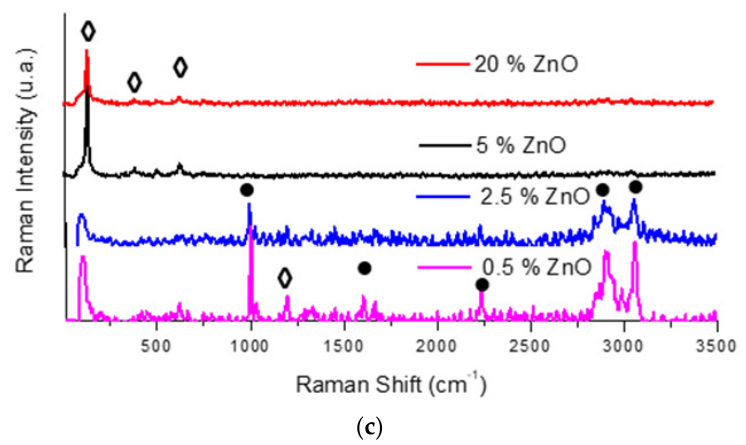
Figure 6. ( a ) Raman spectra of 20% micro- and nano-ZnO-ABS printed composite materials; ( b ) Peak analysis of Raman spectrum for 20% micro-ZnO-ABS; and ( c ) Raman spectrum for micro-ZnO-ABS composites as a function of ZnO concentration.